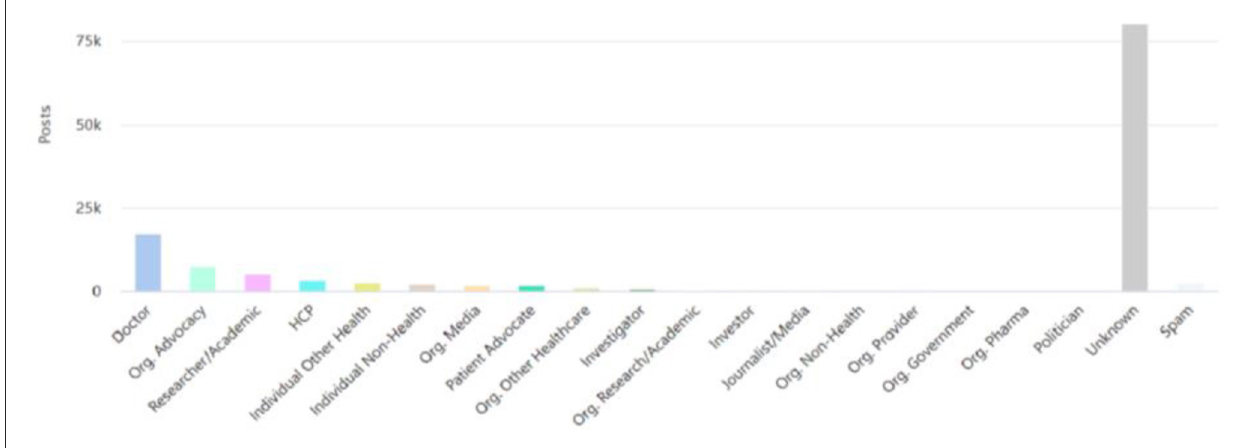
FIGURE1 Number of tweets shared by major healthcare stakeholders.